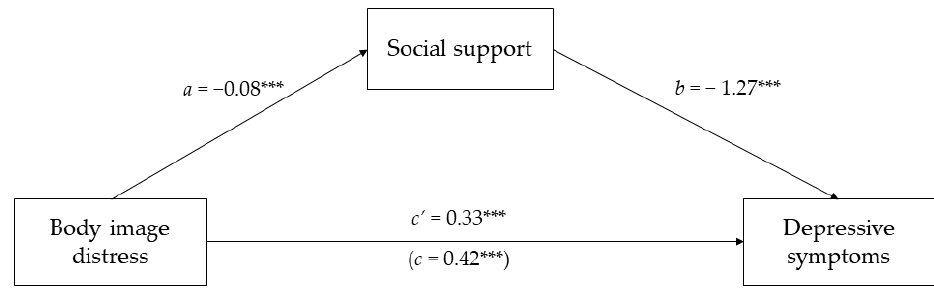
Figure 2. The mediated effect of social support on the relationship between body image distress and depressive symptoms. *** p < 0.001. All values are beta coefficients.